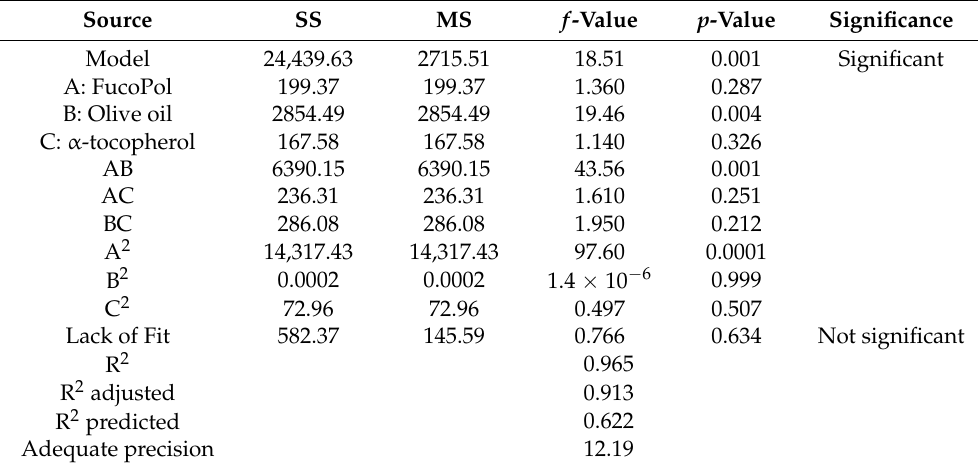
Table 5. ANOVA for response surface quadratic model. (SS)—Sum of Squares shows the variance of values; (MS)—Mean Square is the arithmetic mean of the squared differences; p -value < 0.05 indicate model terms are significant.